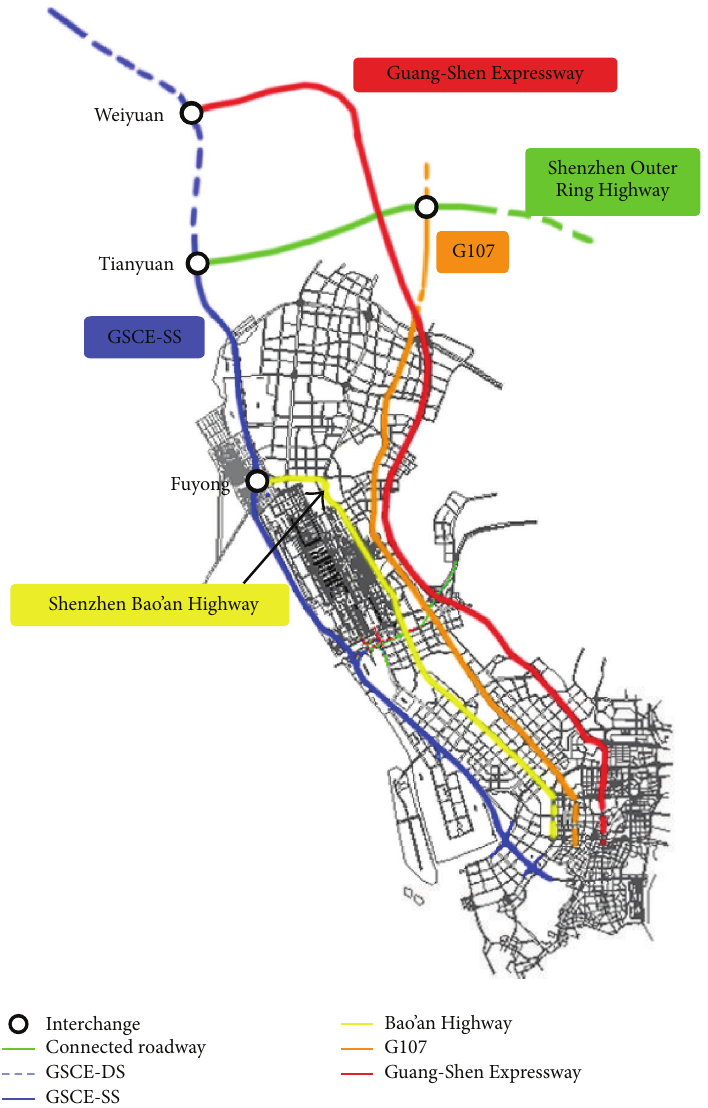
Figure 4: The map of paralleled roadways, connected roadways, and critical control nodes for